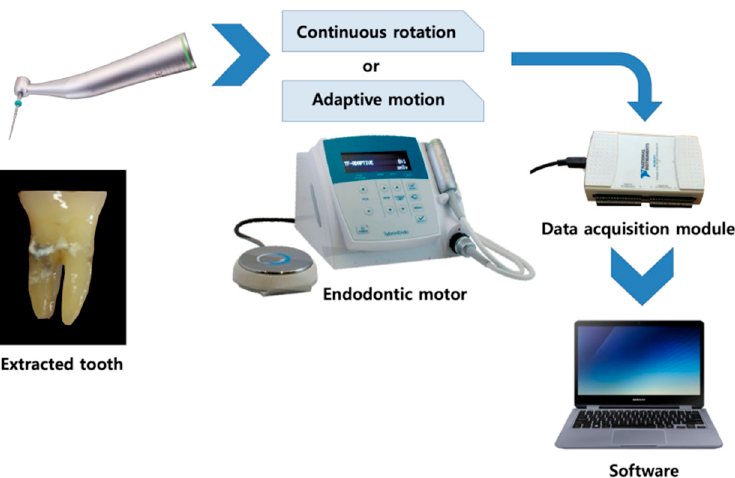
Figure 1. Diagram for test setup. Extracted teeth were used and two modes of kinetics of file movement were applied. The torsional load during instrumentation was recorded using a custom device and program.